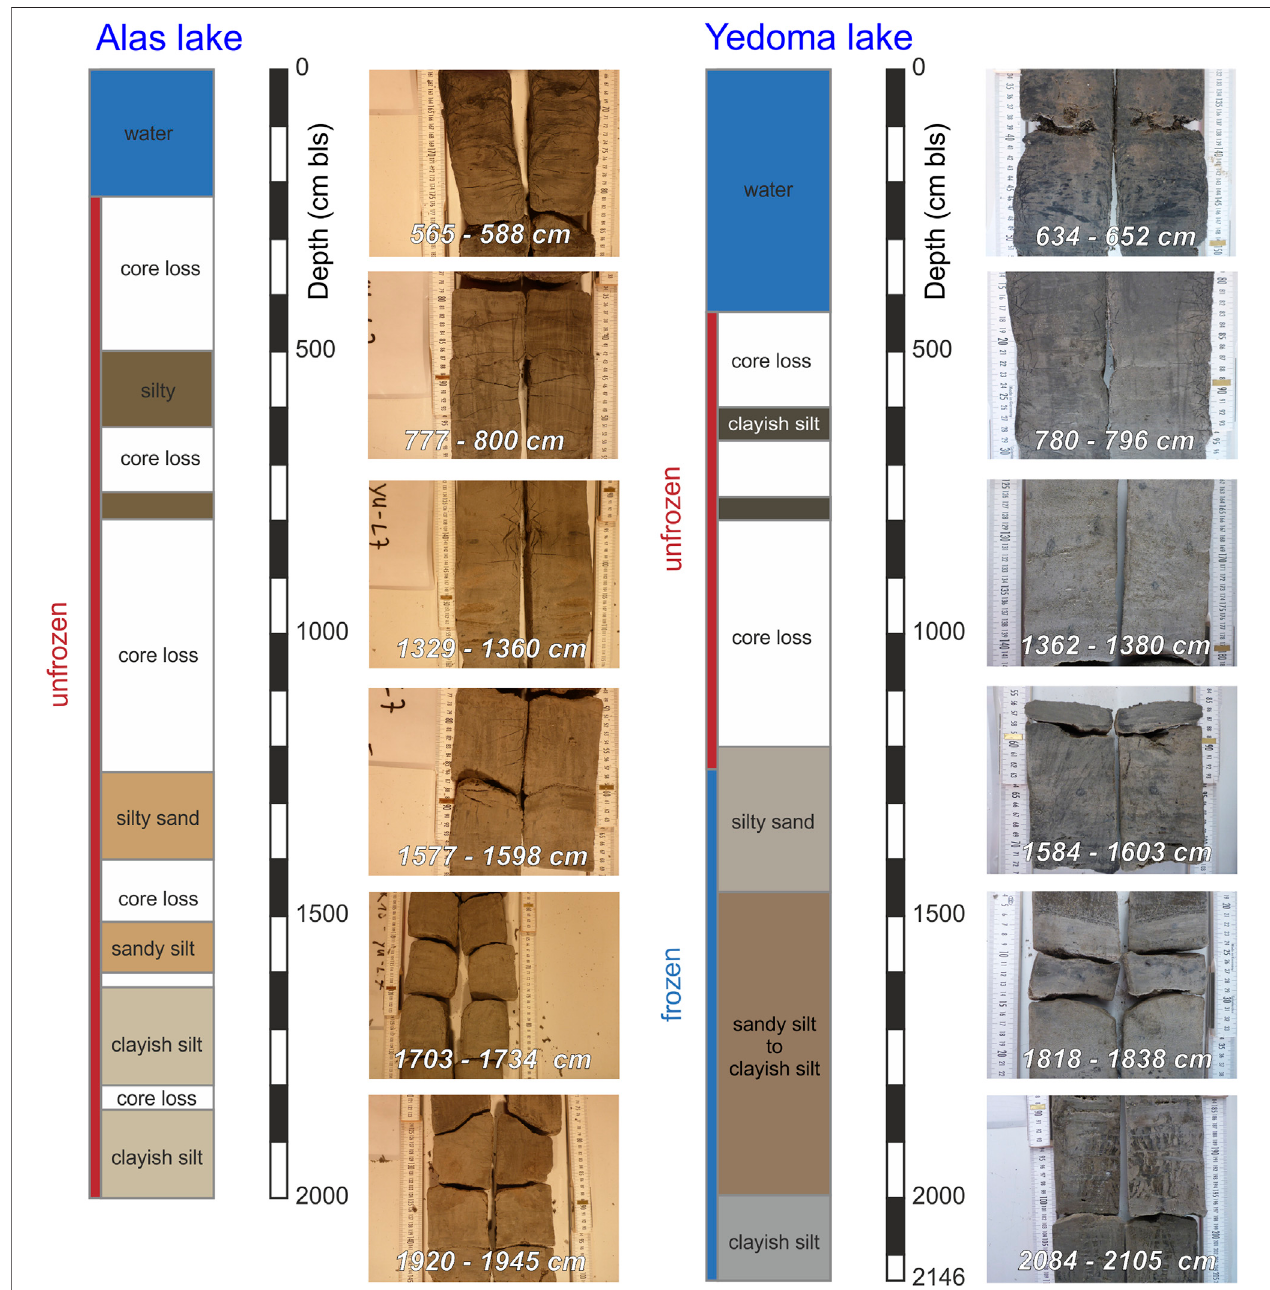
FIGURE3| Corepro fi les ofthe alaslakecoreYU-L7andthe Yedoma lakecoreYU-L15 with dominant sedimentlayersdue tocolor, grainsizeand cryostructures.